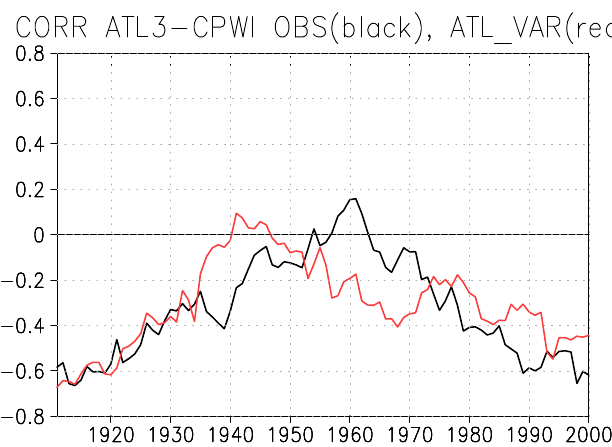
Figure 9. Correlation of the ATL3 index with a central Pacific wind index (CPWI; defined as average near-surface zonal wind in the region 160 ◦ E to 190 ◦ E, 5 ◦ S to 5 ◦ N) for observations (black curve) and ATL_VAR (red curve). Note that absolute correlations of about 0.36 may be considered as 90% statistically significant for 21-year running